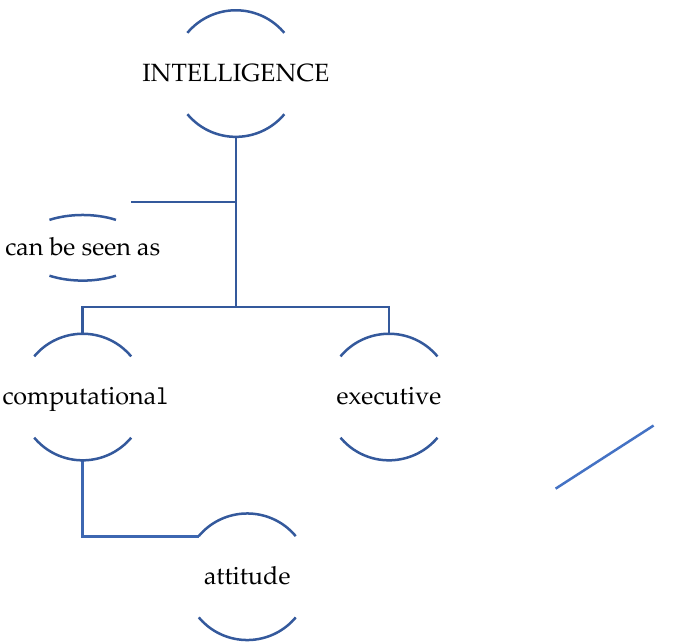
Figure 2. Attitude is a voluntary disposition of intelligence; designed by the authors.